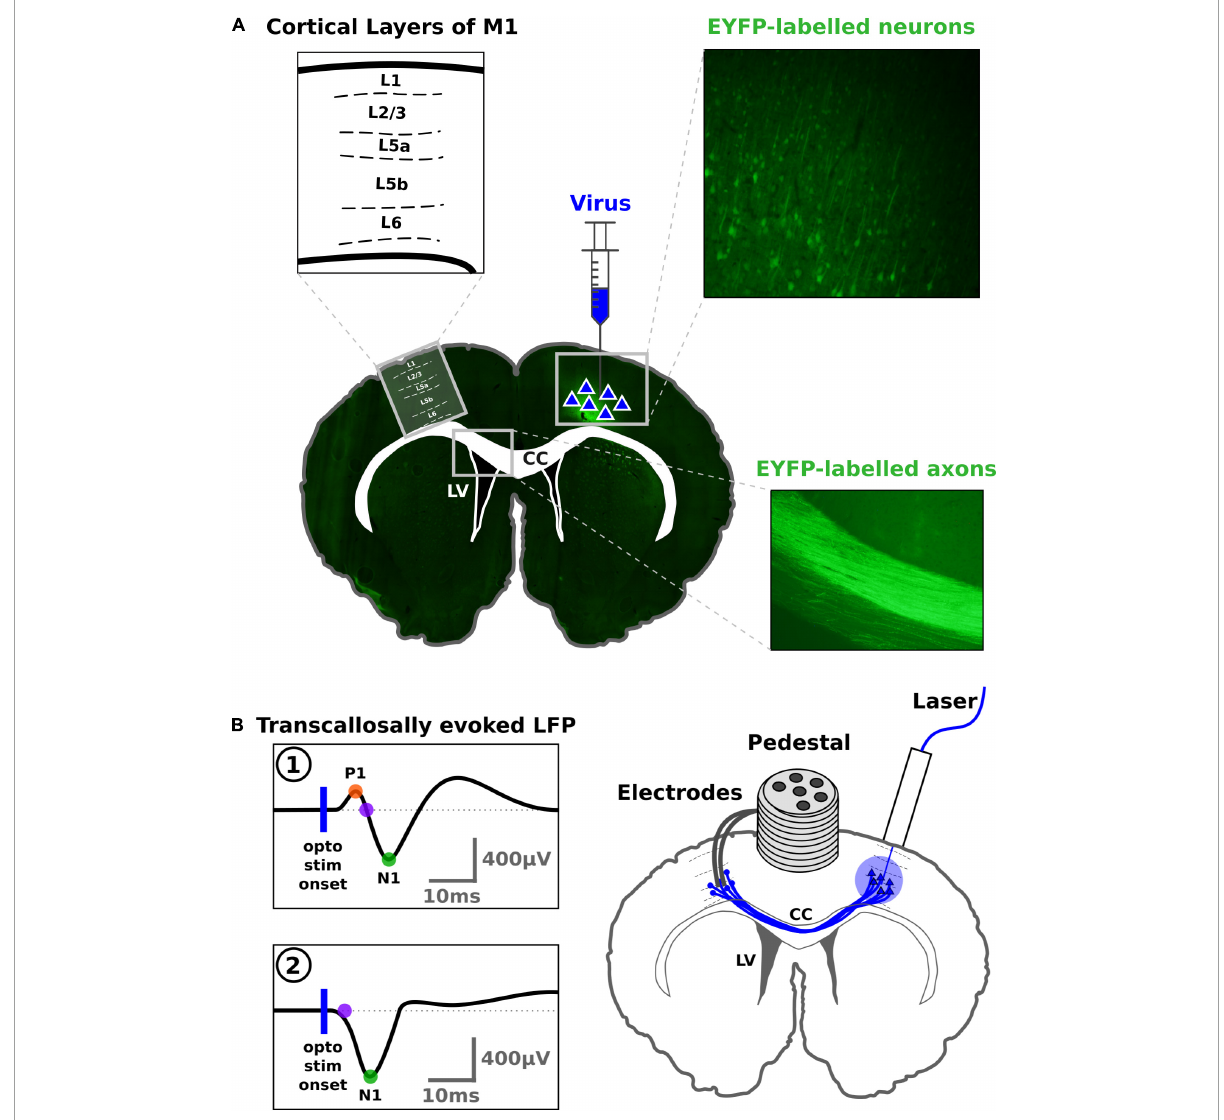
FIGURE1 Synopsis of the optogenetic and electrophysiological experimental procedures. The anatomical drawings depict a coronal section (adapted from microscopy images) of the rat brain at approximately +1.00 mm anterior to bregma, according to Paxinos and Watson (1998). The black filled areas indicate the lateral ventricles (LV), while the white central area in the brain corresponds to cerebral white matter, including corpus callosum (CC). (A) The viral optogenetic construct was injected in L5 of right M1. As a result, Channelrhodopsin2 (ChR2) and Enhanced Yellow Fluorescent Protein (EYFP) were expressed in the neurons at the injection site and along those axonal projections, projecting to the contralateral hemisphere via the CC. Bright green color in the fluorescence microscopy inserts in CC corresponds to EYFP expressed alongside ChR2. (B) An optic fiber was implanted in right M1 for optogenetic excitation of the transcallosal excitatory projection fibers from right to left M1 (depicted as blue lines). A stereo-electrode was implanted in contralateral left M1 to record transcallosal evoked local field potentials (LFP) after optogenetic stimulation of the contralateral cortex. Transcallosal LFP responses displayed two morphologies which are illustrated in the left lower part of the figure. (1) The majority of LFP responses showed an initial positive deflection followed by a second negative deflection. The first positive peak (P1) is marked by an orange dot. The first negative peak (N1) is marked by a green dot. The onset latency of N1 (purple dot) was interpolated to the baseline, based on the slope around mid-maximum of the N1 peak. (2) Some LFP responses lacked an initial positive component and started directly with a negative deflection (purple dot). The vertical blue line depicts the onset of optogenetic stimulation.